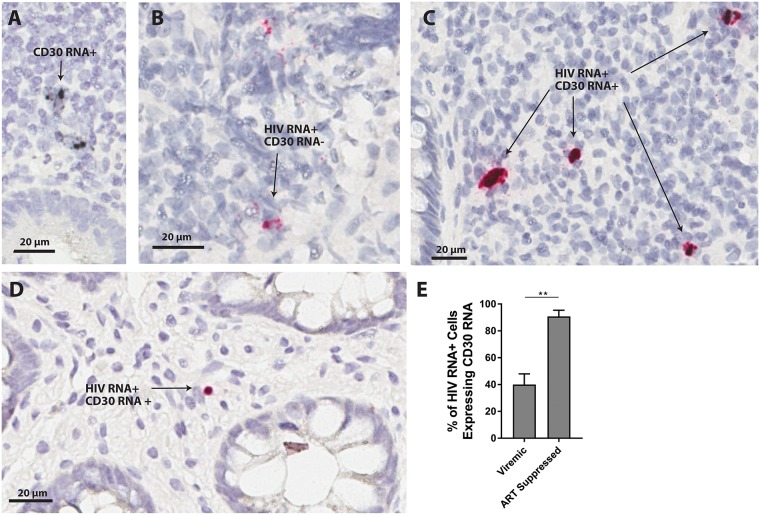
Cell-associated HIV-1 RNA and CD30 RNA co-localize in human rectal and ileal tissue from HIV-1-infected individuals.In situ chromogenic hybridization staining of HIV-1 RNA (pink) and CD30 RNA (black) was performed in ileum and rectum from HIV-1-infected individuals. Less than 0.1% of uninfected GALT cells expressed CD30 RNA (A). Although HIV-1 RNA+ staining alone was identified in sections from GALT from viremic HIV-1-infected individuals (n = 3) (B), 33% of HIV-1 RNA+ cells also expressed CD30 (C). In GALT from ART-suppressed individuals (n = 3), 88% of all HIV-1 RNA positive cells co-expressed CD30 (D). Percentages of HIV-1 RNA+ expressing CD30 RNA are shown in (E). 308 HIV-1 RNA+ cells were observed in sections from all viremic samples and 25 RNA+ cells were observed in tissues sections from suppressed individuals. Nearly all cells with high levels of CD30 RNA also expressed HIV-1 RNA, and minimal background CD30 RNA staining was observed in each field.